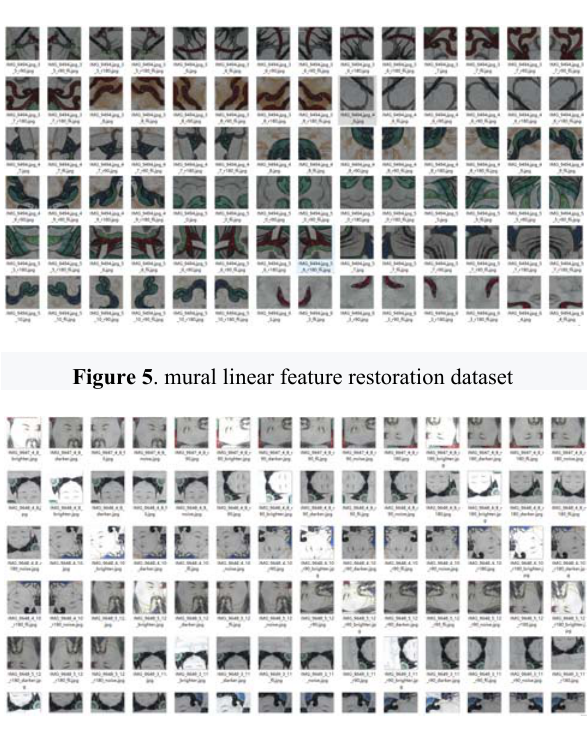
Figure 4 . mural restoration dataset